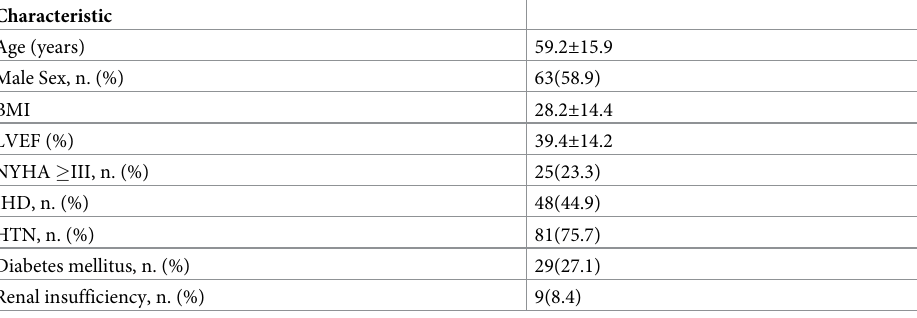
Table 1. Baseline characteristics.